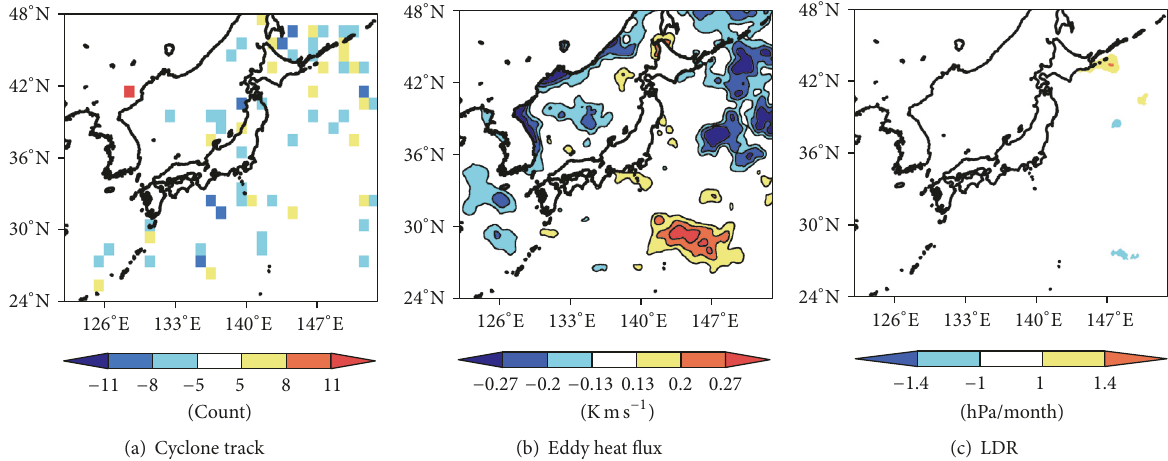
Figure 14: (a) Difference in cyclone track frequency between the SS and CTL runs (former minus latter). (b) As in Figure 14(a) but for the 850 hPa poleward eddy heat flux. The shading interval is 0.07 Kms −1 . (c) As in Figure 14(a) but for the local deepening rate (LDR). Shading interval is 0.4